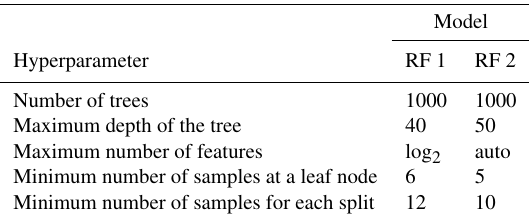
Table B1. Final hyperparameters selected for the optimized models: RF 1 and RF 2. “log 2 ” indicates maximum features are log 2 (no. fea- √ ( no . features ) . tures), and “auto” indicates maximum features are